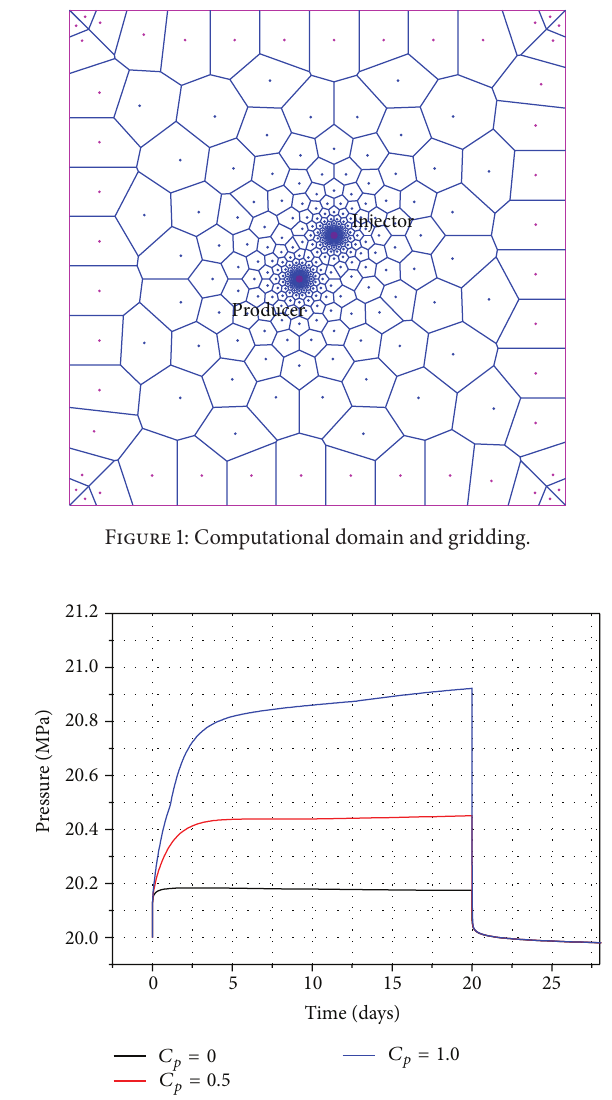
Figure 2: BHP of the injection well for different injection polymer